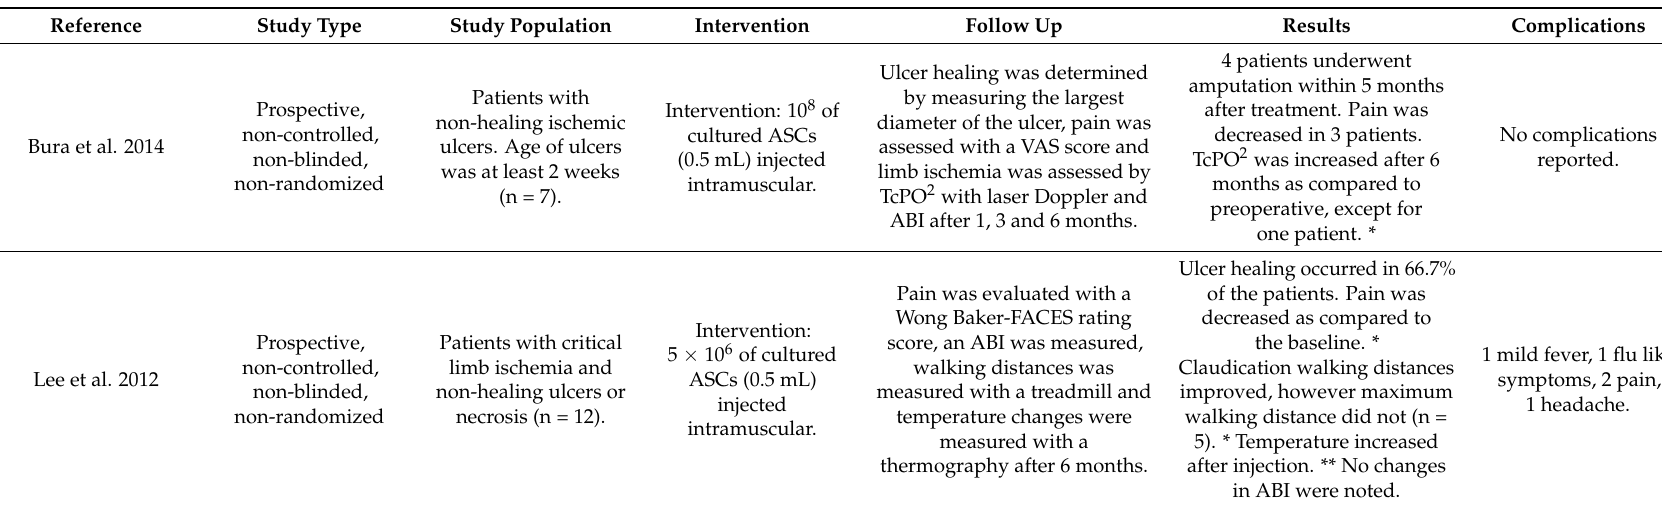
Table 1. Clinical studies of cultured adipose tissue-derived stromal cells (ASCs) as treatment of wound